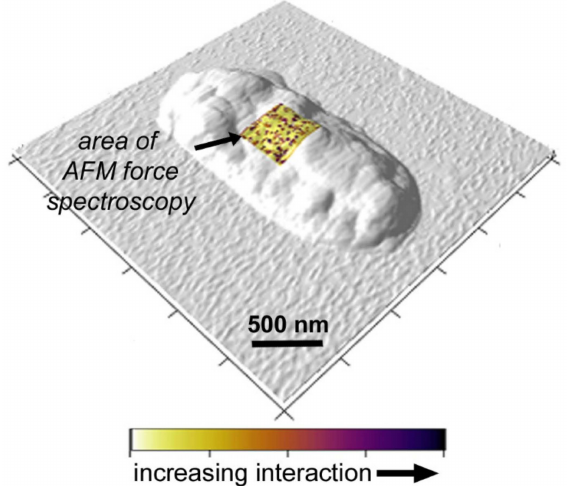
Figure 5. Image showing the force mapping of the Yersinia pestis cell surfaces. Here, the colors of blue-white-red used in Figure 4 are presented as yellow to purple to better show how the surface hydrophobicity varies across the cell surface (dark purple = higher interactions (points of hydrophobicity), white to yellow = no interaction). A 500 × 500 nm 2 area of the cell is